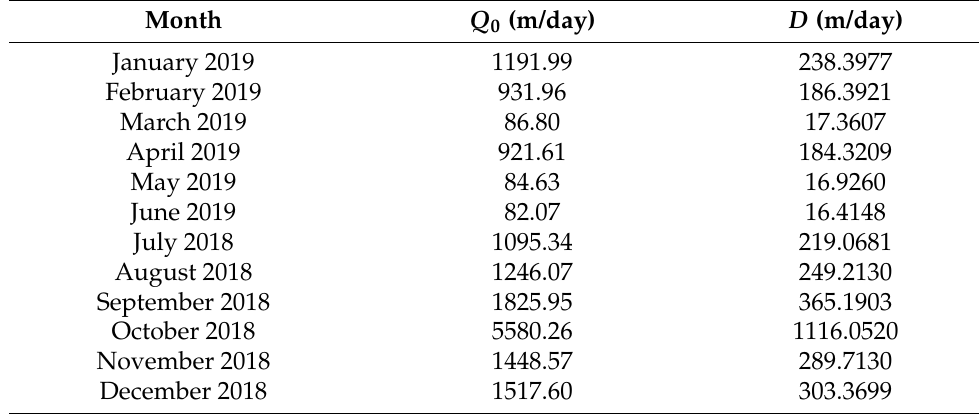
Table 3. The amplitude of the longshore transport rates and the longshore transport rates.